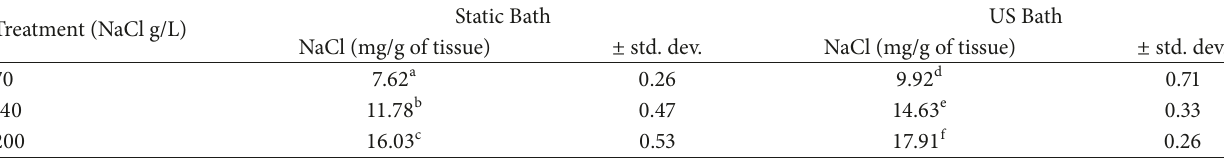
Table 1: Effect of marinade treatments on NaCl uptake of rabbit meat at the end of marinating process (120 min). Treatment (NaCl g/L)